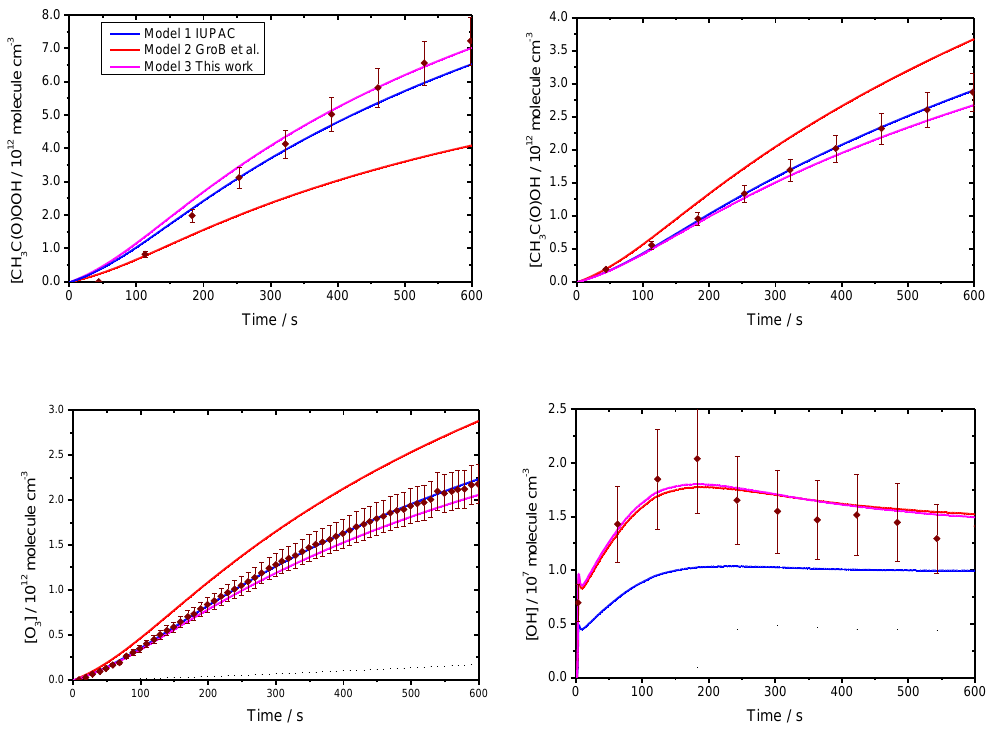
Figure 5. Comparison of the measured CH 3 C(O)OOH (a) , CH 3 C(O)OH (b) , O 3 (c) , and OH (d) with various modelling scenarios, dis- played as a function of time for experiment P2 conducted at 1000mbar and 293K. Error bars are representative of the uncertainty in the FTIR (for a – c ) and FAGE (d) measurement techniques to ± 2 σ . Chemical simulations were conducted with different k (R5) and branch- ing ratios α (R5a) : α (R5b) : α (R5c) . Model 1 (IUPAC): k (R5) = 1.4 × 10 − 11 cm 3 molecule − 1 s − 1 , α (R5a) : α (R5b) : α (R5c) = 0.44:0.15:0.41. Model 2 (Groß et al., 2014b): k (R5) = 2.1 × 10 − 11 cm 3 molecule − 1 s − 1 , α (R5a) : α (R5b) : α (R5c) = 0.23:0.16:0.61. Model 3 (This